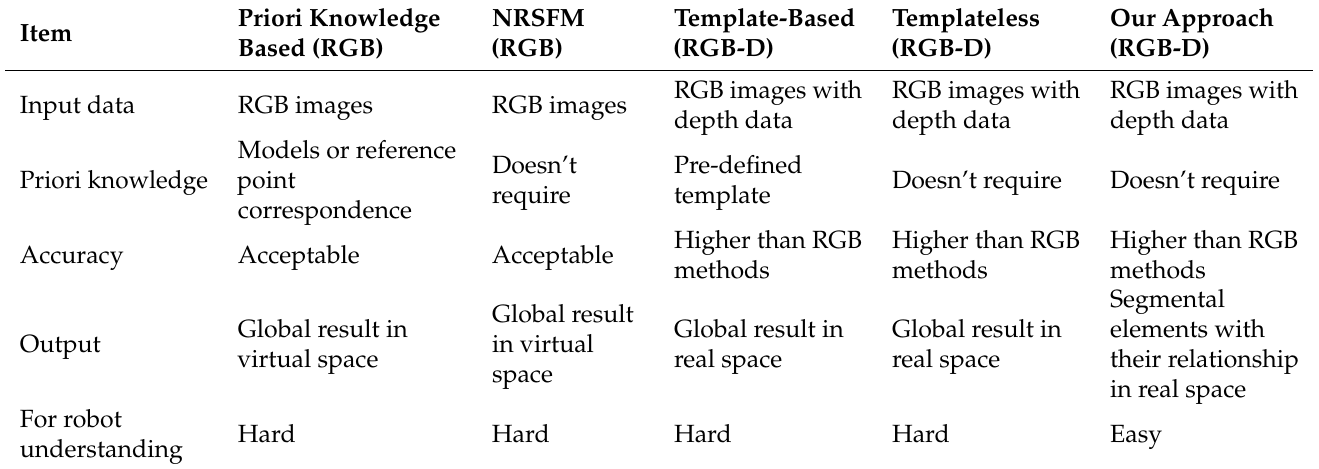
Table 1. Comparative